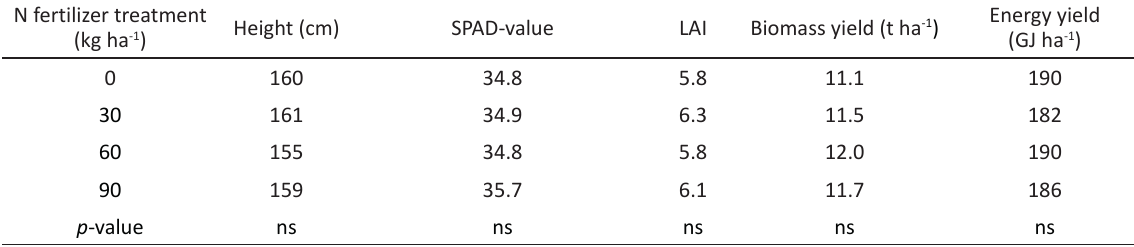
Table 4. Height, SPAD-value, leaf area index (LAI), above-ground biomass and energy yield of Jerusalem artichoke grown at four N fertilizer rates during two growing seasons (2010 and 2011) in Helsinki, Finland. N fertilizer treatment (kg ha -1 )